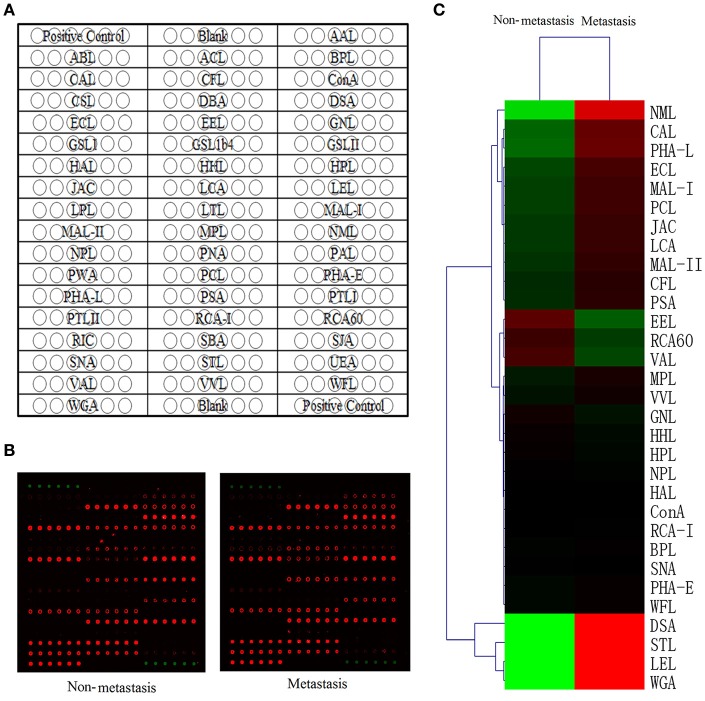
Lectin microarray analysis of glycoforms. (A) The lectin microarray contains 50 lectin spots with different binding specificities. (B) Scan image of the lectin microarray incubated with biotinylated proteins and Cy5 labeled streptavidin. Typical glycan profiles of HCC with metastasis were shown on the right and HCC with non-metastasis on the left. (C) Hierarchical clustering of positive lectin binding spots (S/B≥2). Each row represented a single lectin, S/B values were shown by the color scale: red represents a lectin with high S/B value while green represents a lectin with low S/B value.